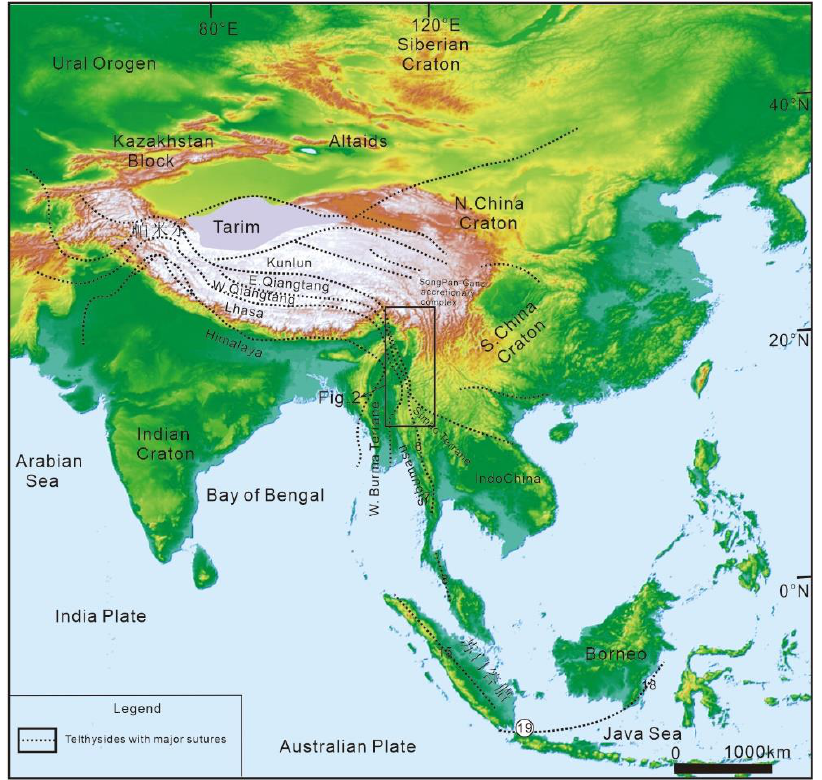
Figure 1. Geological map showing the tectonic framework of the Sanjiang Tethyan Orogen and its adjacent areas. Adapted with permission from Ref. [17]. Copyright 2016